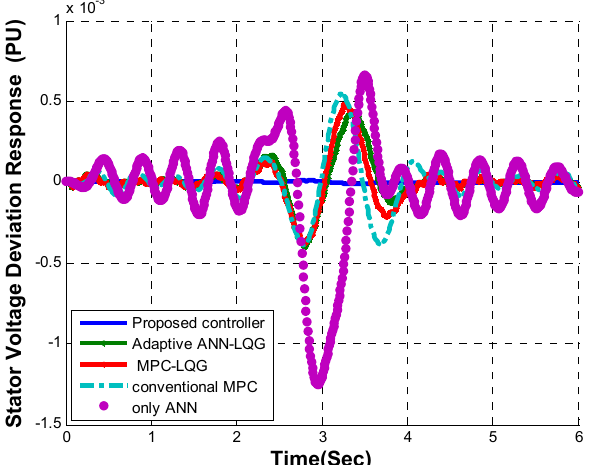
Figure 10. Shaft deflection angle response.